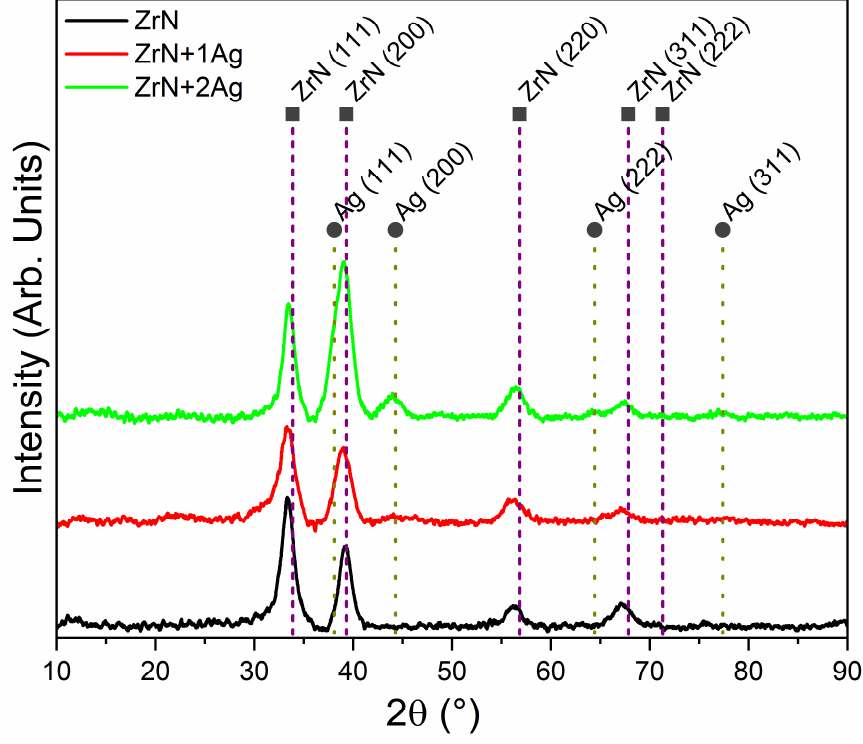
Figure 6. XRD pattern of the deposited coatings: ZrN, ZrN+1Ag, and ZrN+2Ag on a common glass substrate.